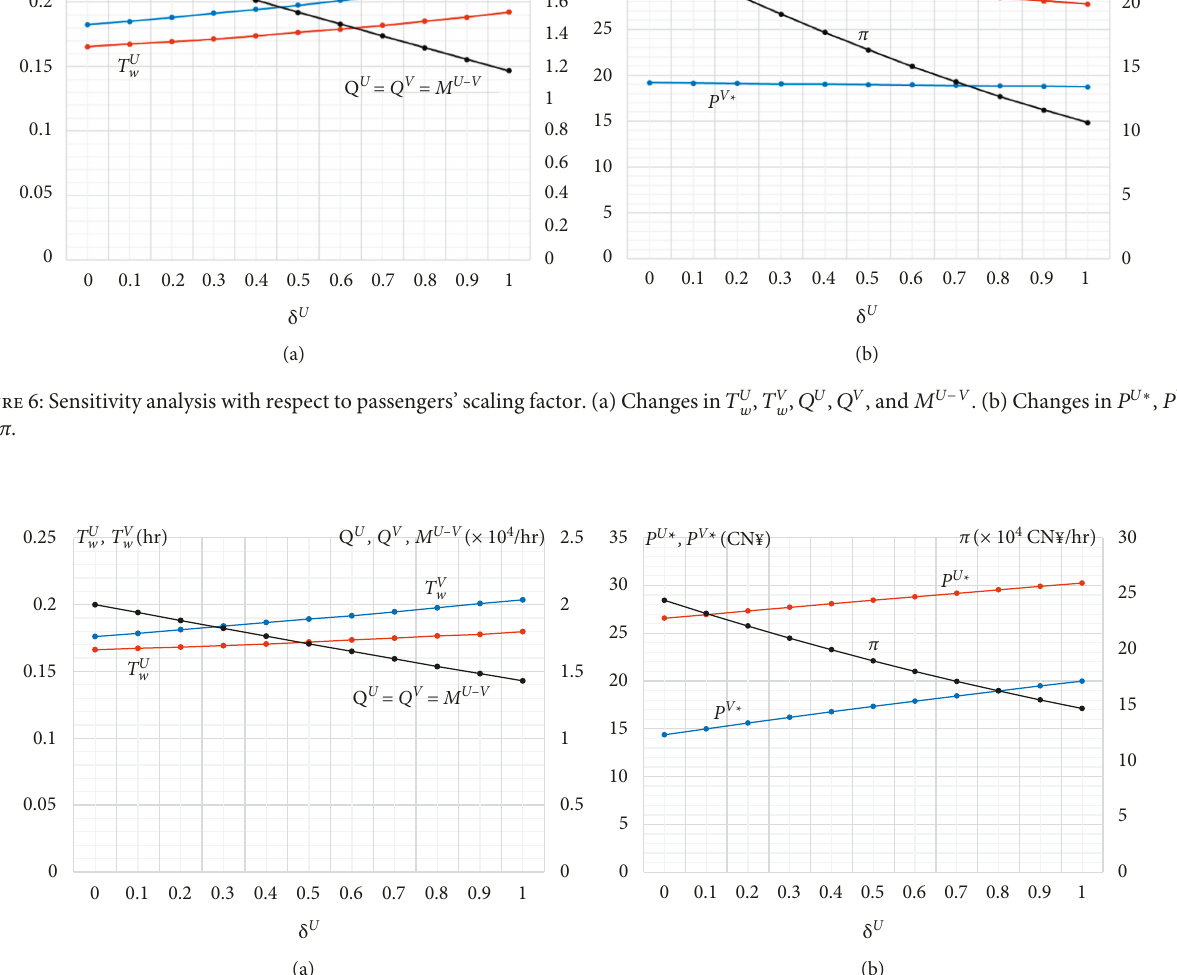
T V Q U , Q V , and M U − V . (b) Changes in P U ∗ , P V ∗ , and w , w ,